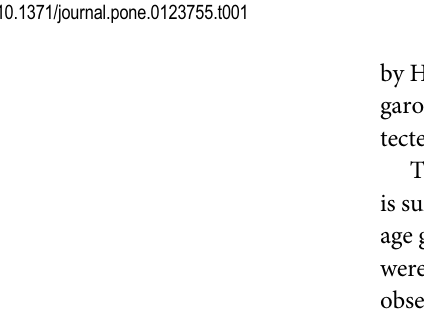
garovirus, and enteroviruses accounted for 197 (9.7%) cases. The details of the other viruses de- tected are shown in S1 Table.